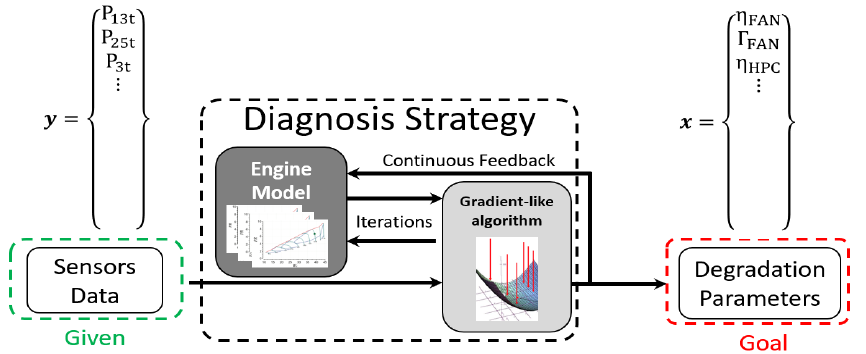
Figure 3. Diagram of the diagnosis